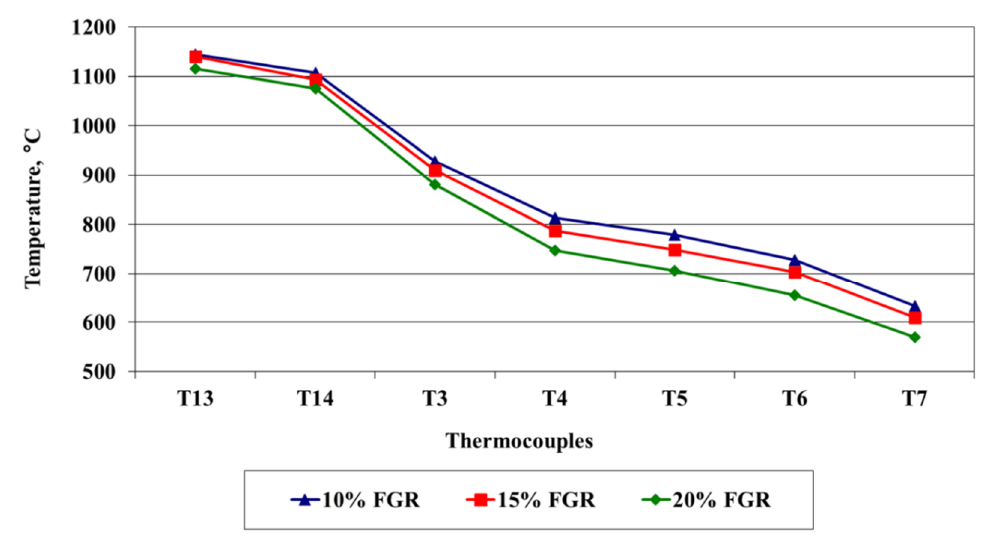
Figure 10. Effect of increasing flue-gas recirculation share on the course of the temperature field through the furnace at burner power input 16 kW and air excess coefficient m = 1.1.